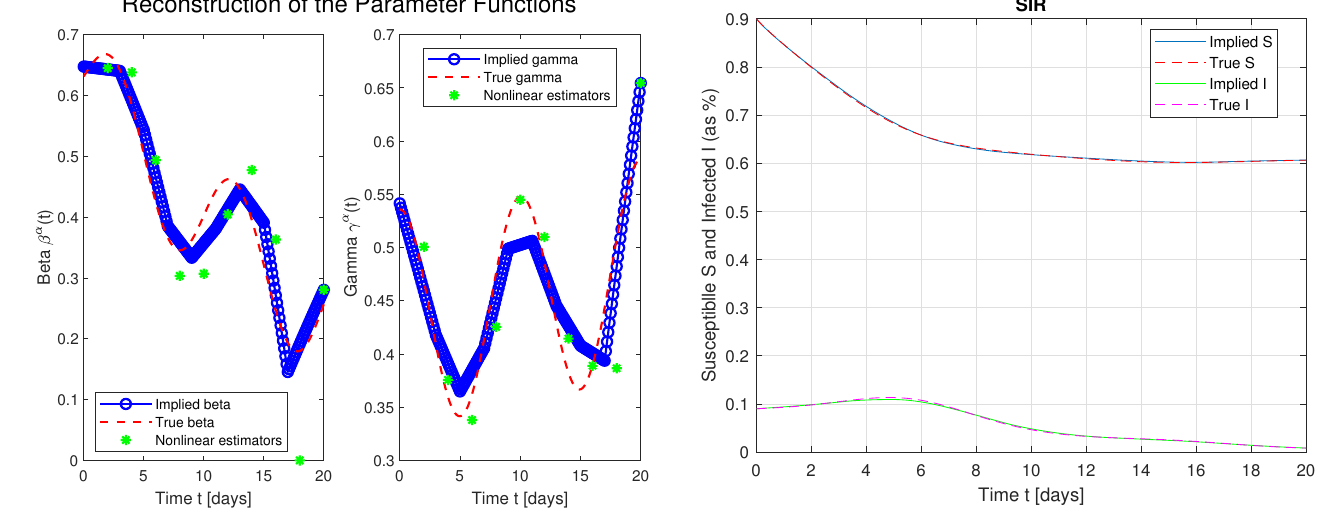
Figure 7. Recovered parameters β α ( t ) and γ α ( t ) with (14) ( left ); recovered susceptible S and infected I population with (14) ( right